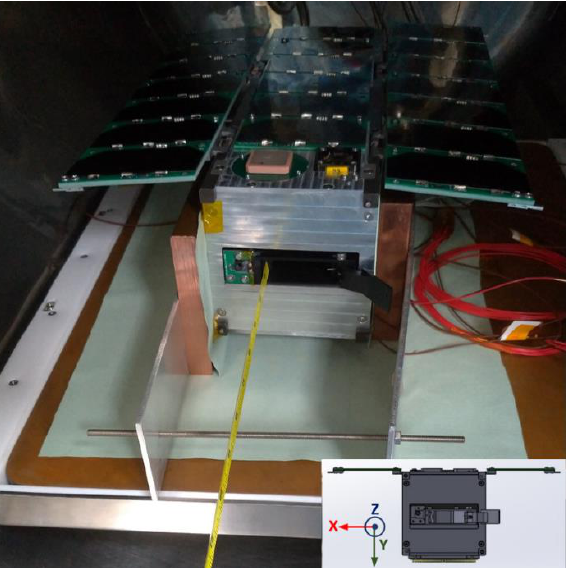
Figure 14. The configuration of IDEASSat during the thermal vacuum cycling test.